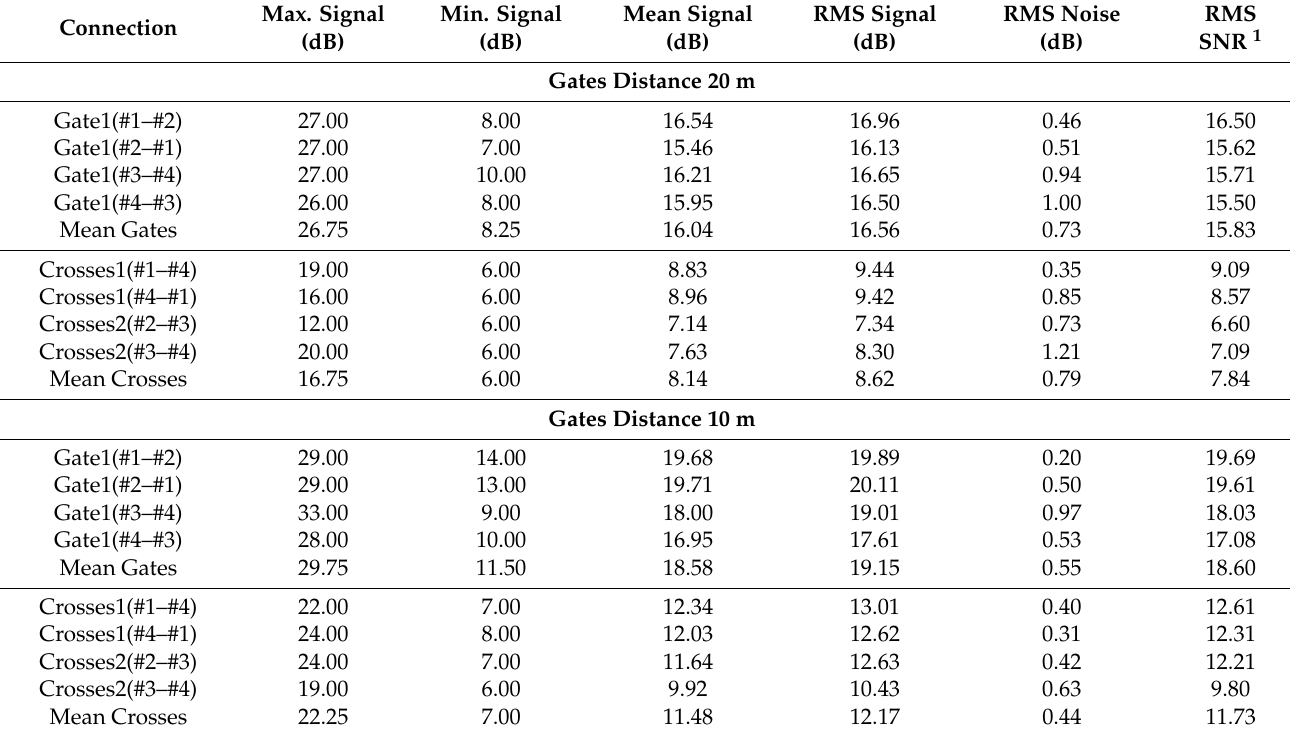
Table 6. RSSI measurements from communication transmissions during the test with 20 m of distance between